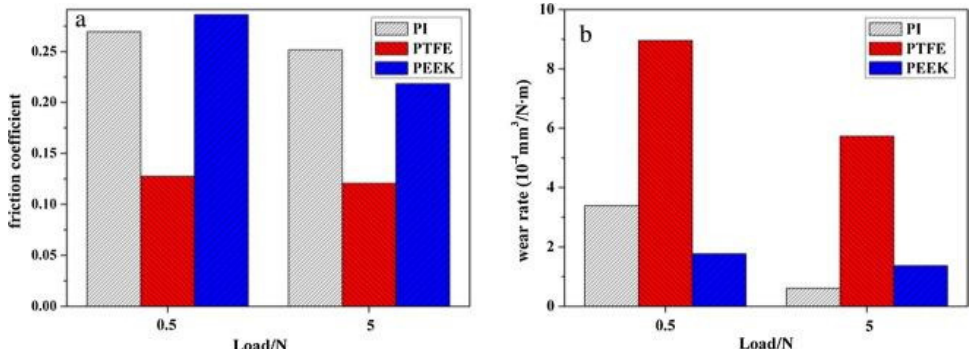
Figure 15. The variation in (a) CoF, (b) wear rates of three different polymer matrix-based composite tested in a vacuum at − 50 °C . Reproduced with permission from [109]. Copyright Elsevier, 2016.